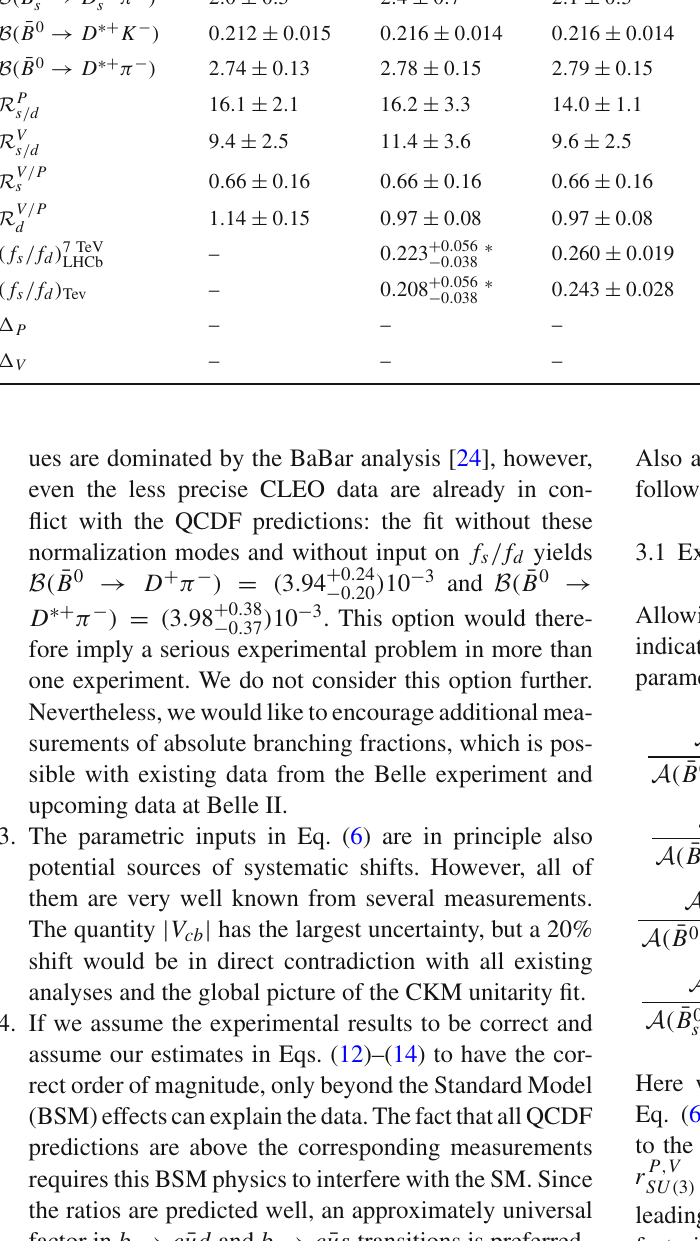
Table 2 Our fits to the available data listed in Table 4 with and without constraints from QCDF, in comparison to the PDG values [15] and our QCDF predictions. The branching fractions are given in units of 10 − 3 . Results marked with a ∗ indicate that the distribution is non-gaussian.